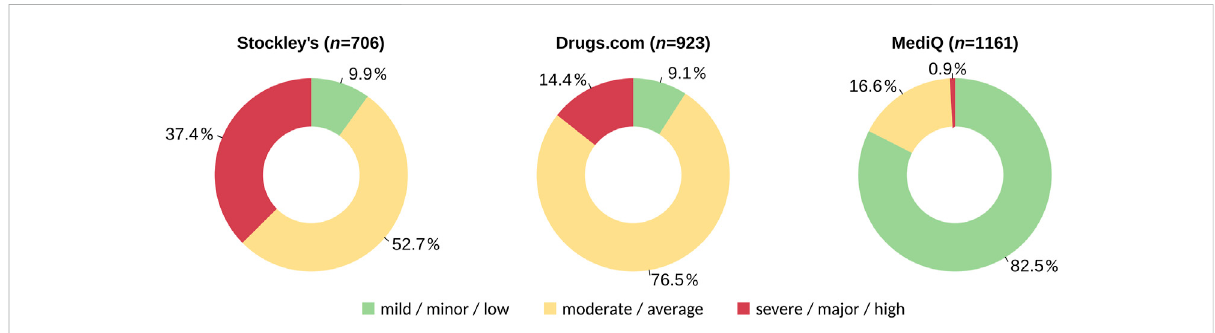
FIGURE 1 Proportions ofmild, moderate and severe potential drug-drug interactions by database. The medication schedules of 627patients with CIS/MS wereevaluatedwithrespecttopDDIsusingthreedatabases.ThedoughnutplotsshowtheproportionsacrossalldifferentpDDIsfound.CIS,clinically isolated syndrome; MS, multiple sclerosis; pDDI, potential drug-drug interaction.